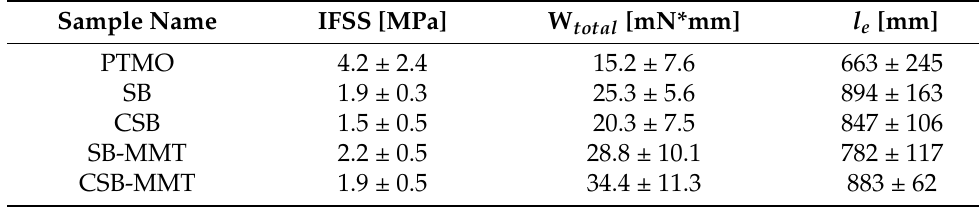
Table 4. Results of SFPO depending on the surface treatment of the ARG